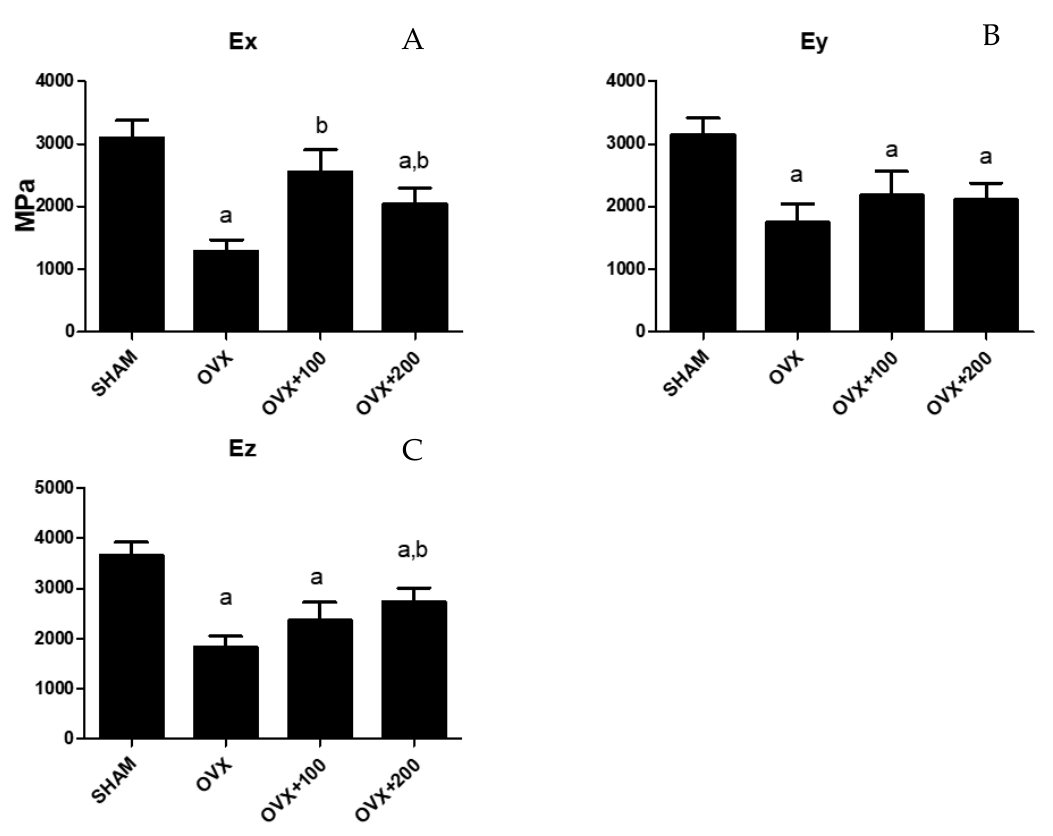
Figure 4. Young´s modulus of the femur obtained in three directions (Ex ( A ), Ey ( B ), Ez ( C )). SHAM operated, ovariectomized (OVX), ovariectomized and treated with olive oil (OVX + 100) (100 µ L / day by oral gavage) and ovariectomized and treated with olive oil (OVX + 200) (200 µ L / day by oral gavage) over 3 months, n = 12. Data are expressed as mean ± SD. Statistical significance: ( a ) vs. SHAM; ( b ) vs. OVX. Ex: OVX vs. SHAM p < 0.001, OVX + 100 vs. OVX p < 0.05, OVX + 200 vs. SHAM p < 0.05, OVX